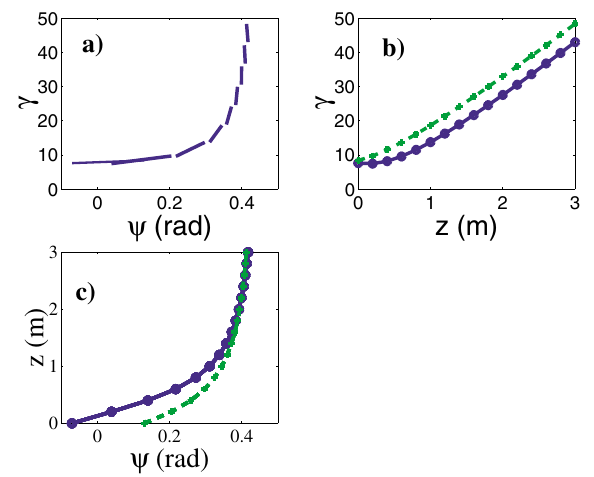
FIG. 1. (Color) Simulation, using a two macroparticles model, of the velocity compression in a 3 m long traveling wave (cid:2) (cid:3) (cid:1) 0 ; 8 (cid:2) and the ; (cid:14) structure. The initial conditions are (cid:1) o o (cid:2) (cid:3) (cid:1) 0 : 1 ; 0 : 4 (cid:2) . Plot (a) ; (cid:14) (cid:14) macroparticle spacing is (cid:1) (cid:14) o o shows snapshots at different z of the longitudinal phase space. Each segment’s extremities are determined by the two macro- particles positions. Plots (b) and (c) present the energy gain and phase evolution of the two macroparticles versus z . In these two latter plots, solid lines represent the leading particles and dashed lines the trailing ones.